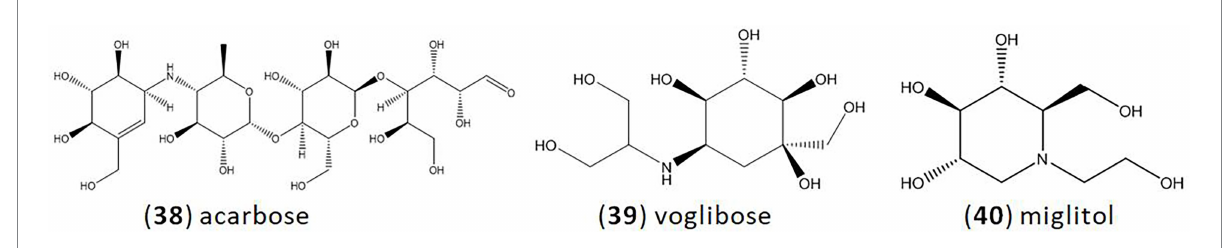
FIGURE 3 Clinical medicine of glycosidase inhibitors. ( 38 ).acarbose; ( 39 ).voglibose; ( 40